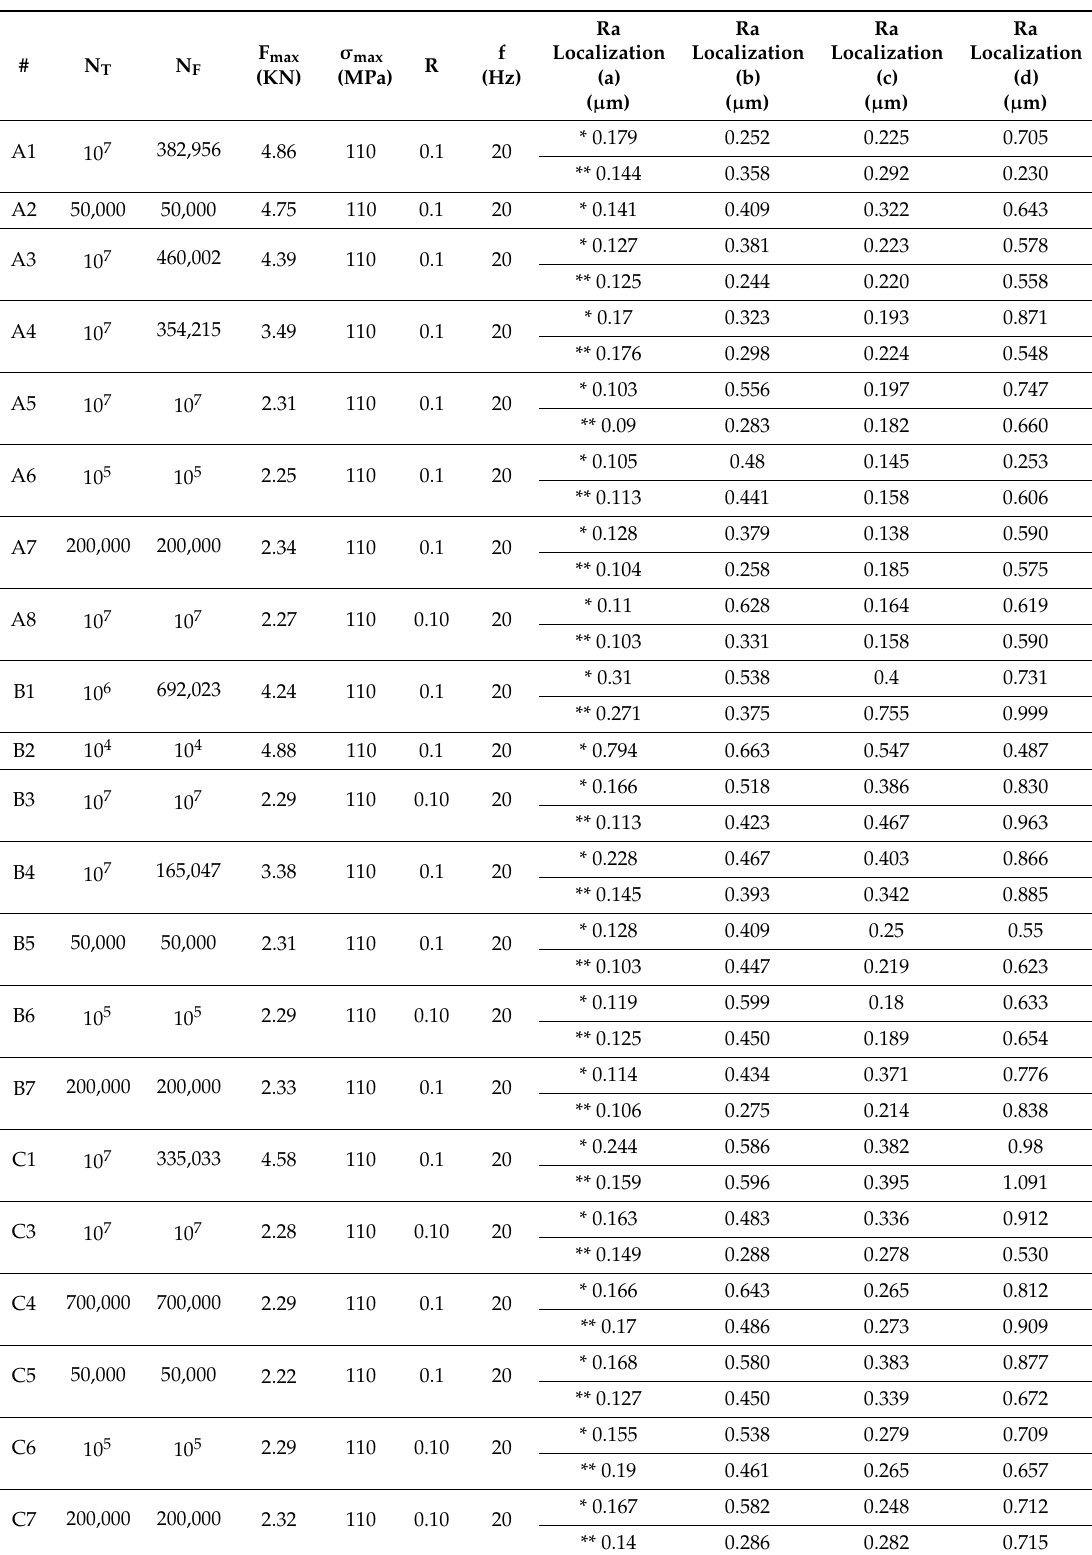
Table 3. Roughness on specimens of aluminum alloy 7075-T6, before * and after ** the conventional fatigue